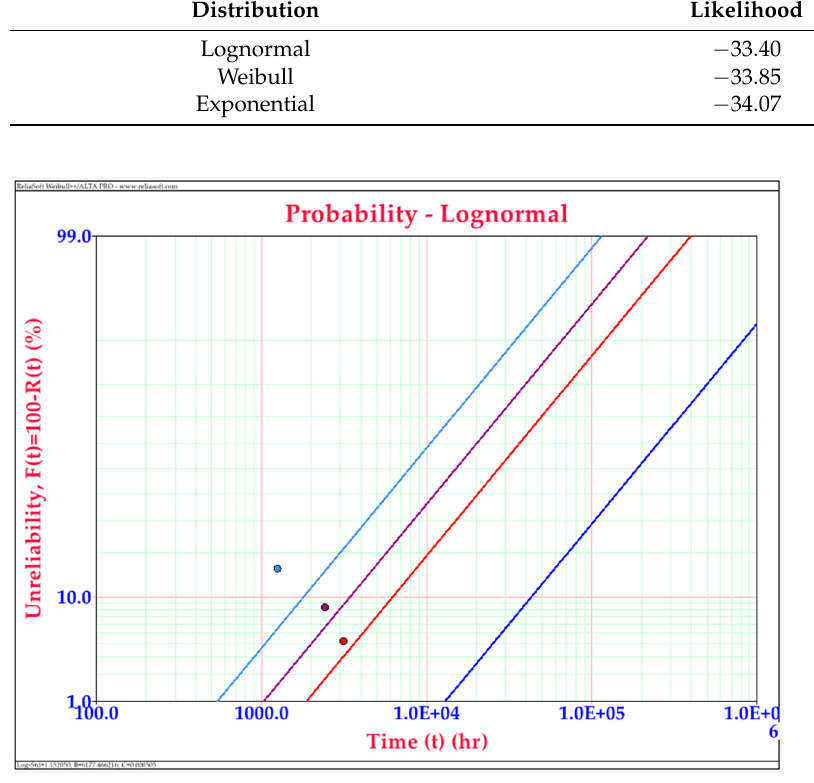
Figure 9. Lognormal probability